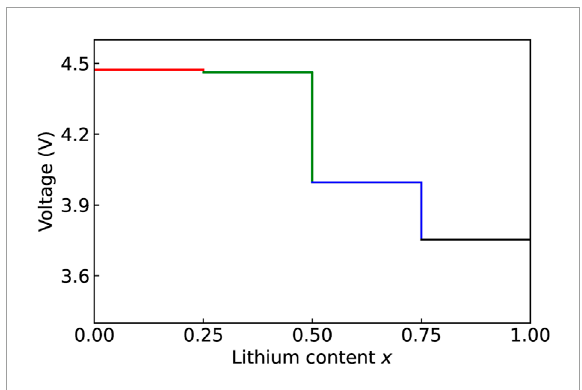
FIGURE 2 Computed specific voltage of Li x NiO 2 as a function of Li content x . be these rescaled to U = 0 . 18 / 0 . 25 ⋅ 7 . 96 eV = 5 . 73 eV. As shown